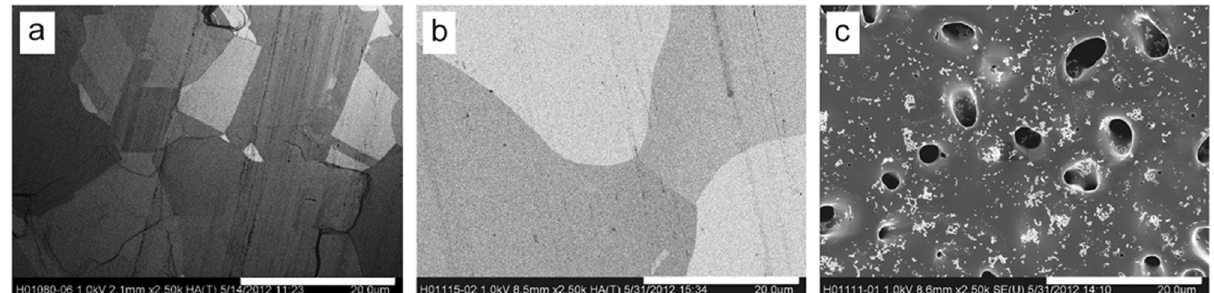
Fig. 5 Scanning electron microscopy results of N-doped graphene. SEM images of N-doped graphene grown on Cu substrates using different precursor treatments (under an H 2 fl ow during growth). Scale bar in each image is 20 µm: a CH 4 , b pyridine, and c nitroethane (reproduced from 86 with permission from the American Chemical